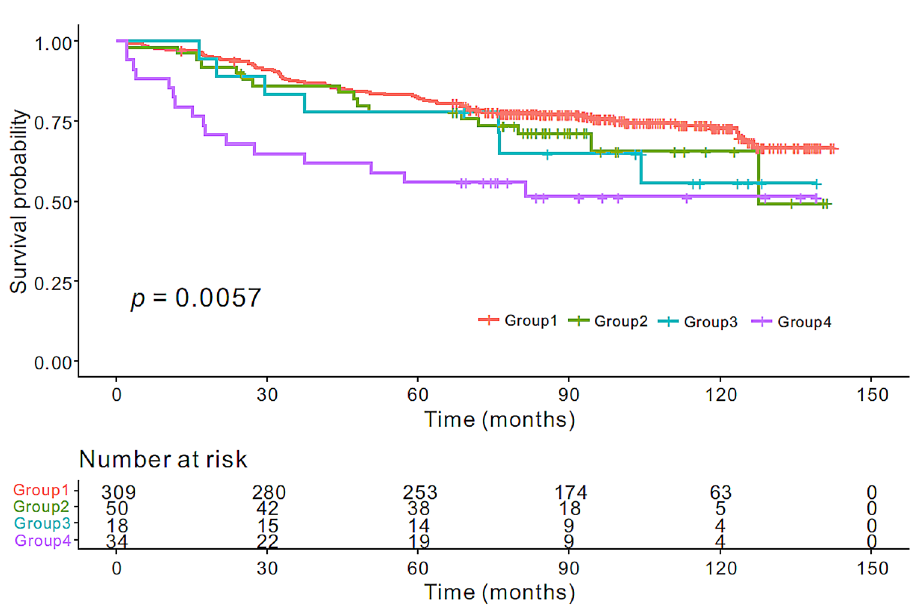
Figure 2. Kaplan–Meier curves of overall survival stratified by the combination of BLR and SLR. Group 1: low BLR and low SLR; Group 2: low BLR and high SLR; Group 3: high BLR and low SLR; Group 4: high BLR and high